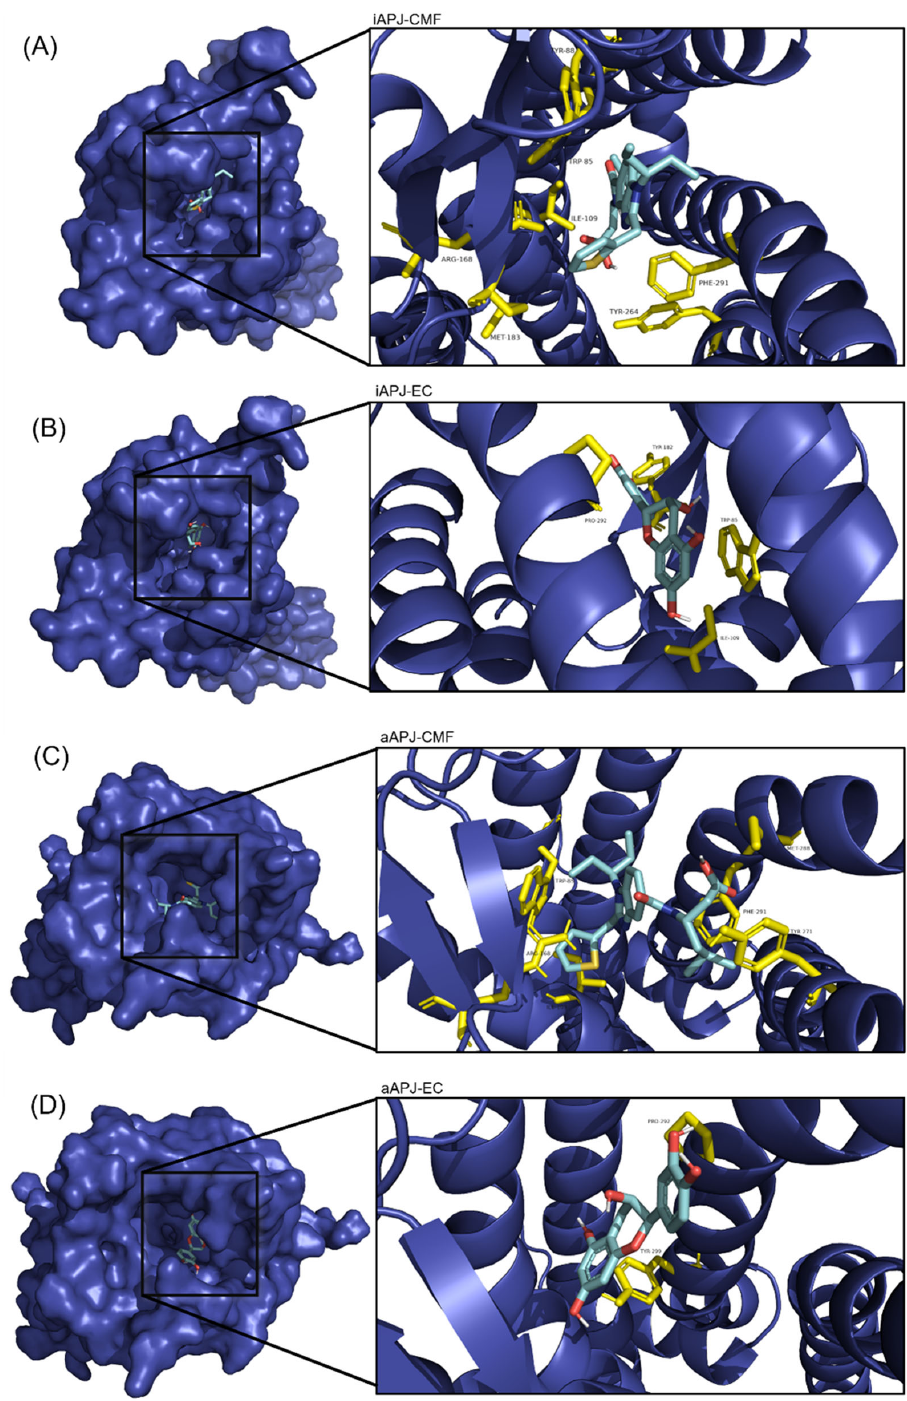
Figure 5. On the left side of each image, the APLN receptor seen from above is shown in a surface representation, and within the cavity (binding site) is the corresponding ligand. A close ‐ up of the binding site is shown to the right of each image, with the amino acid residues in yellow and the ligand in cyan blue. ( A ) The binding site of the CMF ‐ 019 in the inactive APLNR conformation. ( B ) The binding site of the ( ‐ ) ‐ epicatechin in the inactive APLN conformation. ( C ) The binding site of the CMF ‐ 019 in the active APLNR conformation. ( D ) The binding site of the ( ‐ ) ‐ epicatechin in the active APLNR conformation.